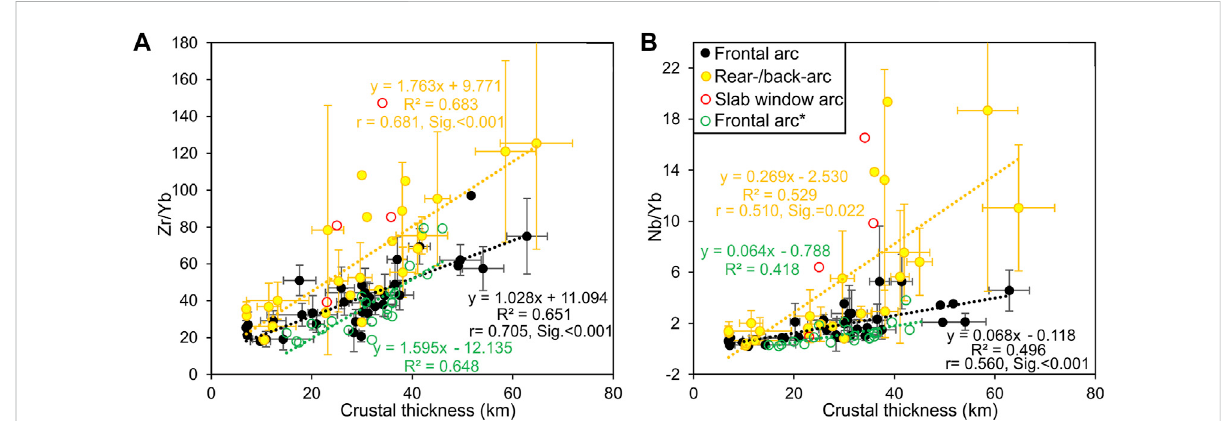
FIGURE 2 Crustal thickness of the overriding plate vs. immobile incompatible trace element ratio Zr/Yb (A) and Nb/Yb (B) . The partial correlation coef fi cient r is calculated when theslab thermal parameter (discussed below) is taken as the control variable, with 2-tailed signi fi cance. The rear-arc in Java (Muriah and Ringgit-Besar volcano) which has extremely high Nb/Yb is excluded in B and other fi gures below. Frontal arc* from Turner and Langmuir(2015)isalsoplottedforcomparison.Asthesetworatiosarenotgivenintheirpapersotheyarecalculatedbasedontheaveragetrace element ratios given in their supplement. For example, Zr/Yb = average La/Yb divided by average La/Zr.